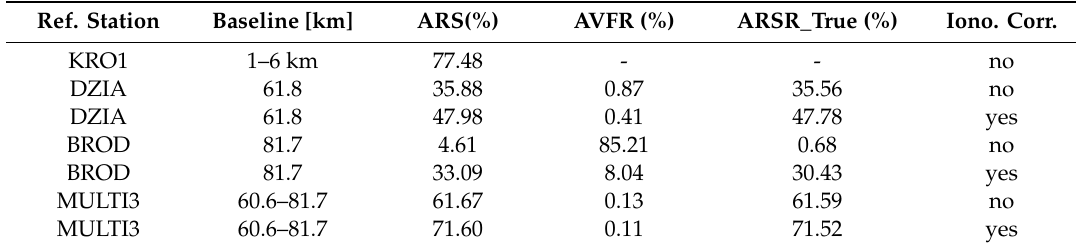
Table 5. Statistical summary of all postprocessed solutions.